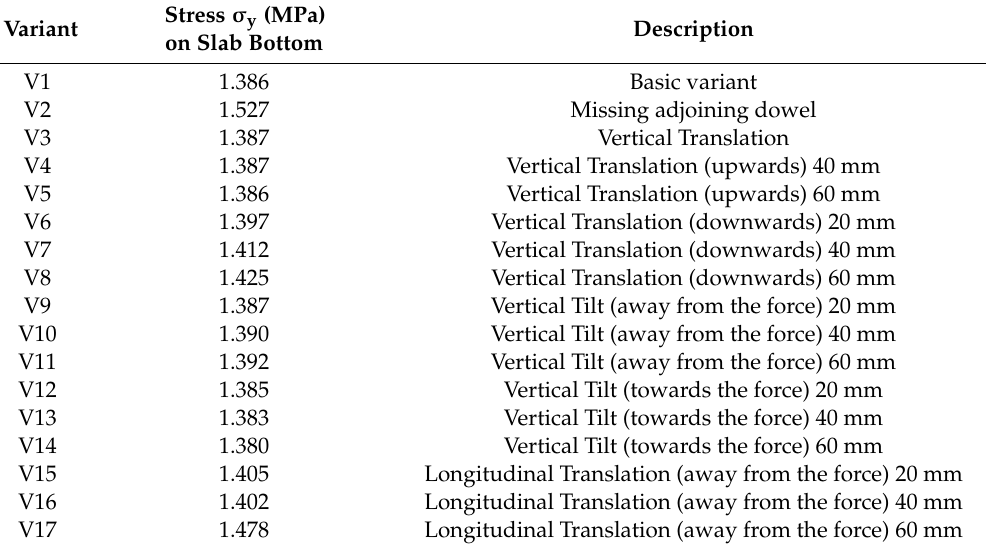
Table 4. Results of stress at bottom part of concrete slab.